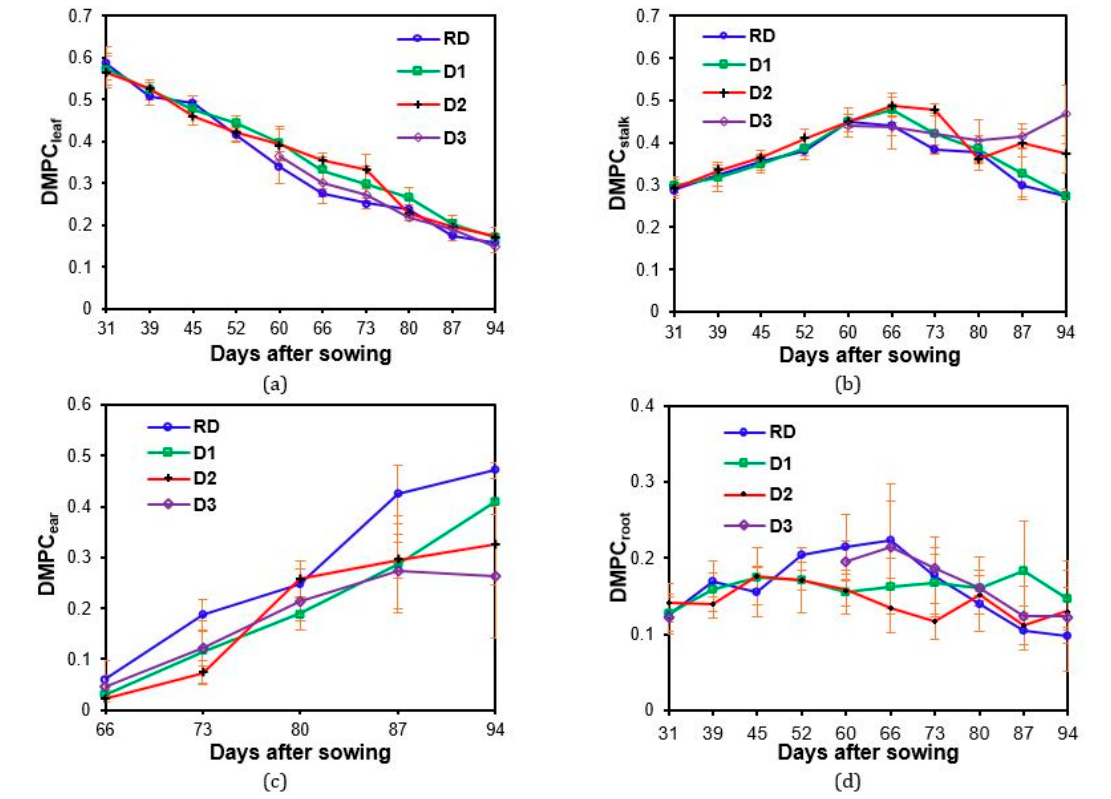
Figure 4. Responses of DM partitioning coefficients to drought stress ( a ) leaf, ( b ) stalk, ( c ) ear, and ( d ) root.